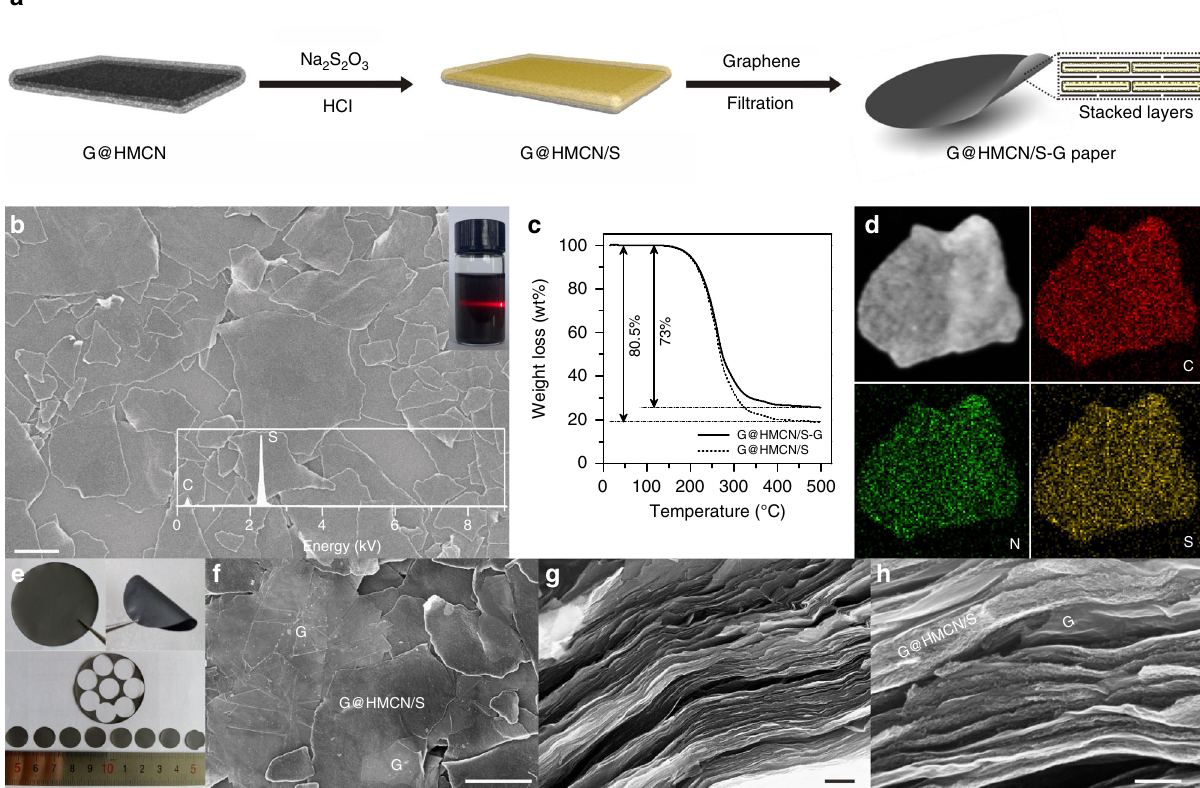
Fig. 3 Synthesis and characterizations of G@HMCN/S-G. a Schematic illustration for the preparation of G@HMCN/S composites and G@HMCN/S-G hybrid paper; b SEM image, c TGA curve, and d scanning TEM image and elemental mapping of G@HMCN/S; e Optical images of the G@HMCN/S-G paper and cathodes, f top-down and g , h cross-section SEM images of the G@HMCN/S-G cathodes Insets: the optical image of the G@HMCN/S dispersion and EDX spectrum of G@HMCN/S. Scale bars, 1 μ m b , f , g ; 200 nm